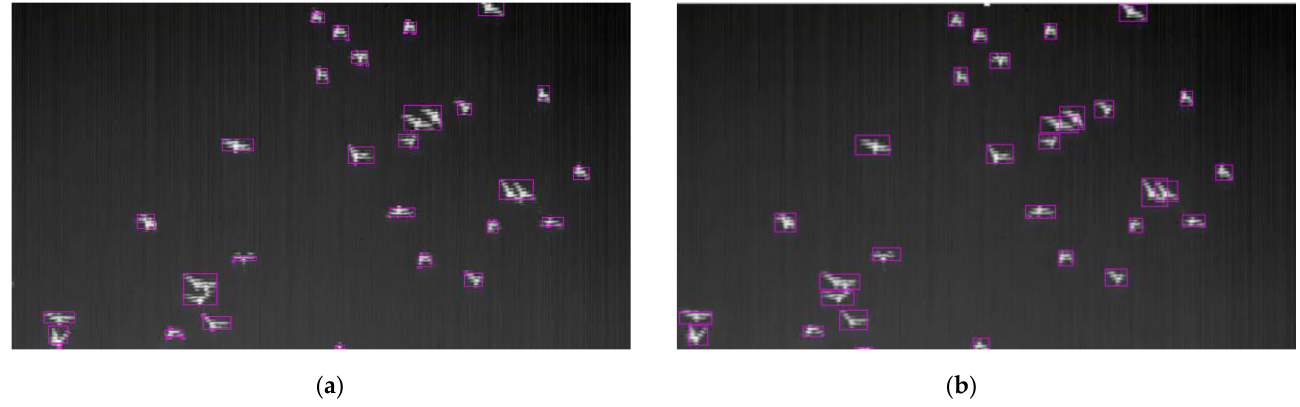
Figure 9. Comparison of first-stage and second-stage detection results on TIV dataset, ( a ) the detection result of TVF; ( b ) the detection result of GHPNet combined with TVF. Table 6. Ablation Experiment.